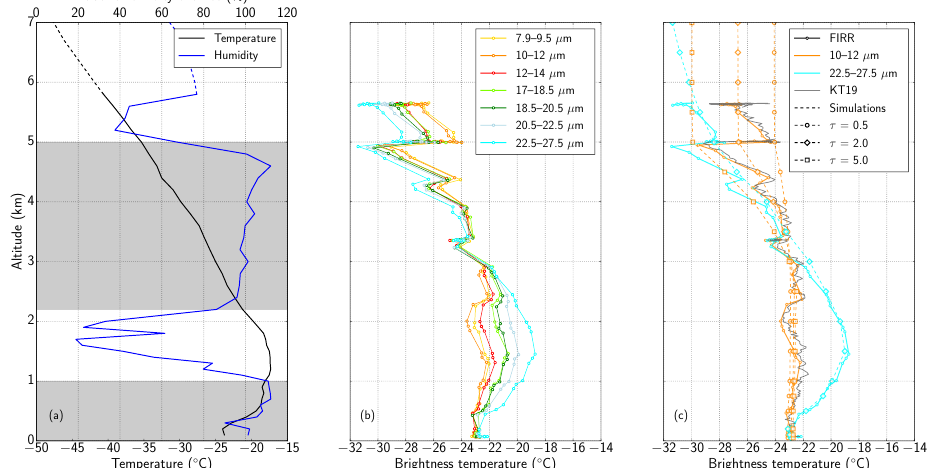
Figure 12. Vertical profiles of (a) temperature and relative humidity and (b) FIRR brightness temperatures for 13 April flight. In panel (a) , the shaded areas indicate the presence of clouds and the dashed lines correspond to the ERA-Interim profiles used for the simulations above maximum flying altitude. Panel (c) shows measured and simulated brightness temperatures for two FIRR bands and various optical depths of the upper cloud. KT19 temperatures are shown as well for comparison to FIRR 10–12µm